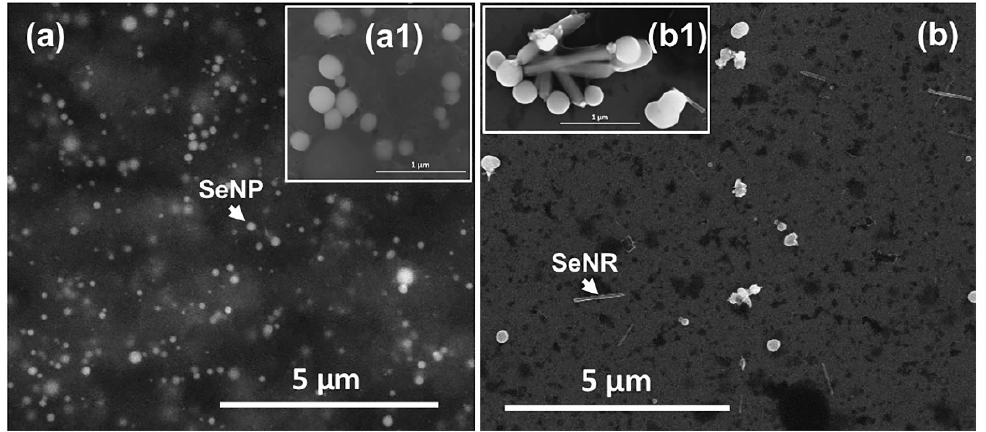
Figure 2: Scanning electron micrographs of ( a , a1 ) Bio SeNP extract and ( b , b1 ) Bio SeNP extract_w. Arrow heads indicate the occurrence of SeNPs and SeNRs, while the inlets ( a1 ) and ( b1 ) displayed the observed SeNMs at high magnification.